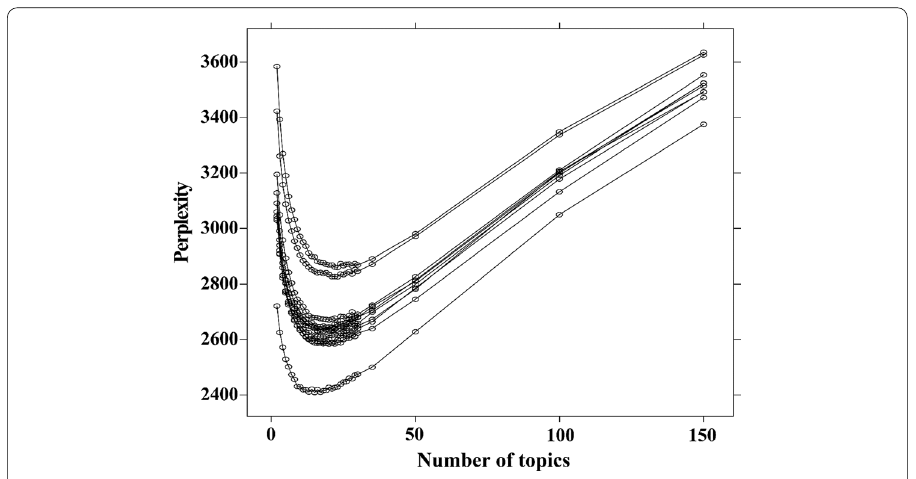
Fig. 2 Perplexity plots by the topic numbers across the ten-fold